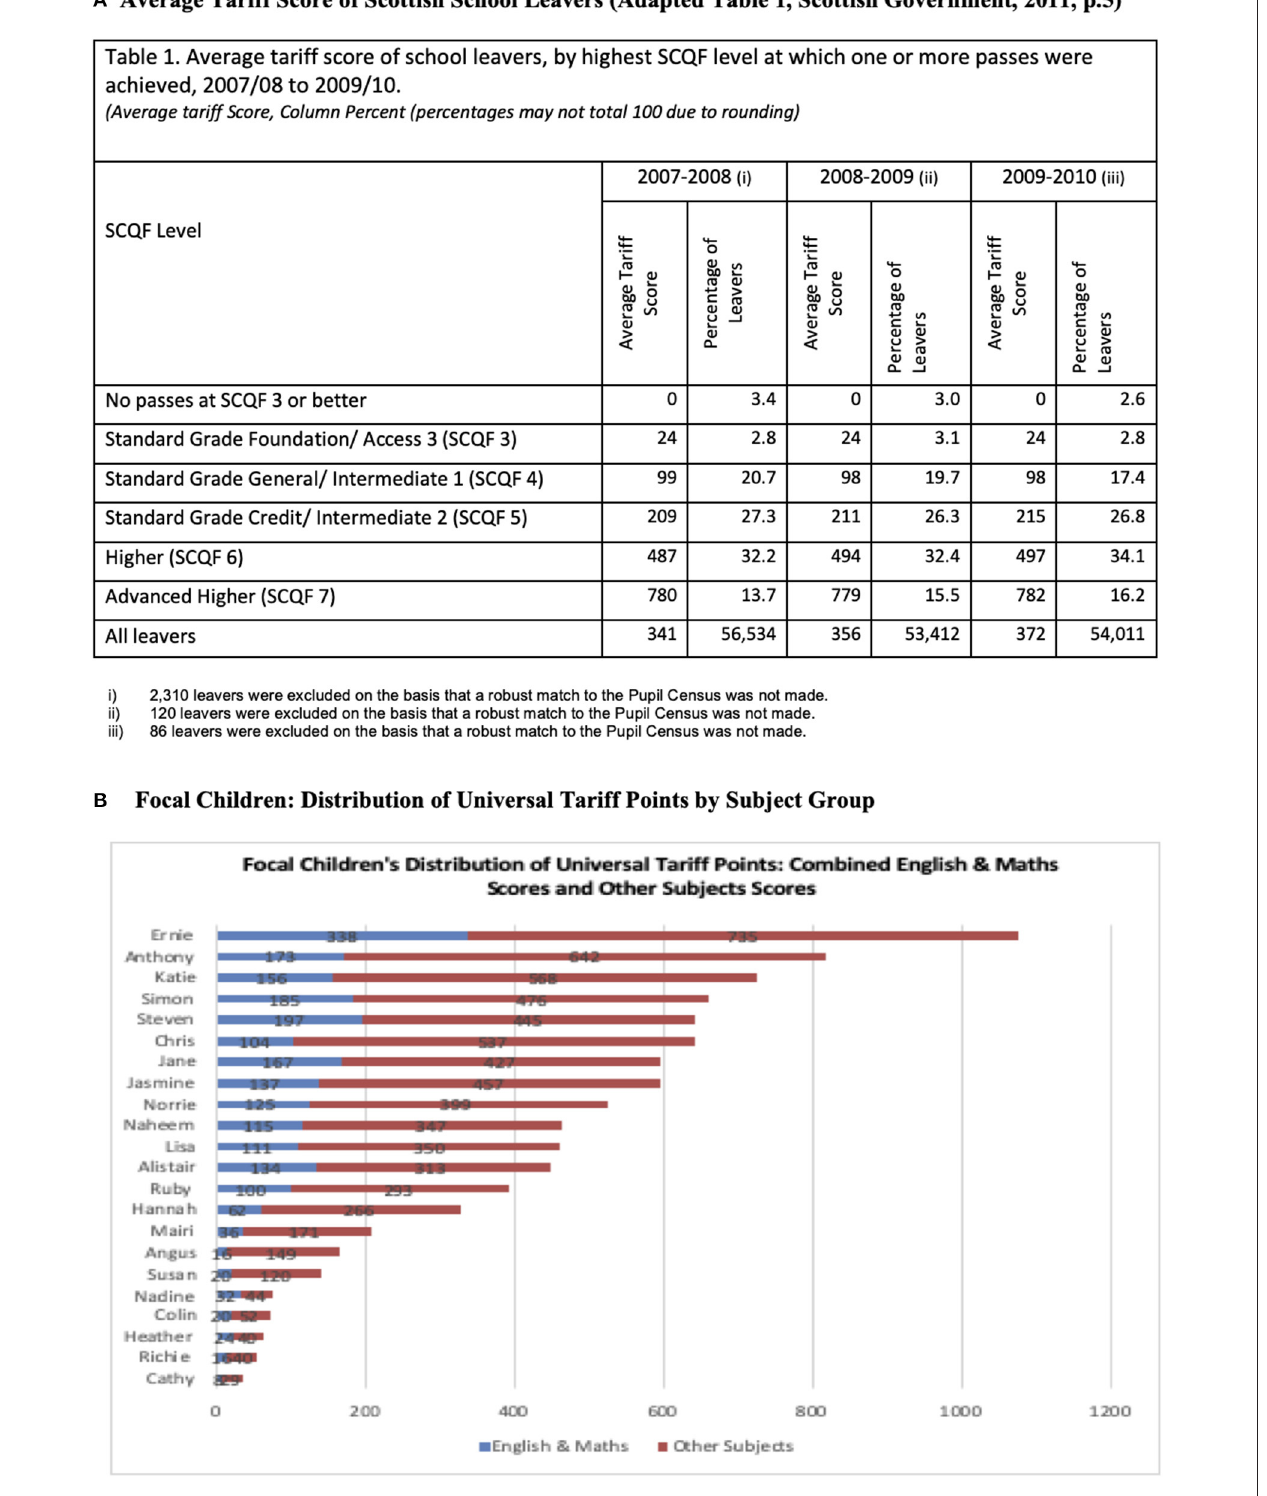
FIGURE 3 | Tariff scores-scottish school leavers and case study